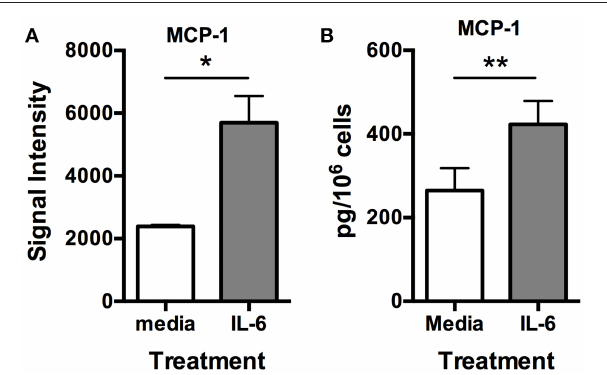
FIGURE 5 | IL-6 induces MCP-1 secretion from human skin mast cells. Human skin mast cells were treated or not with IL-6 (100ng/ml) for 24h, and the media was analyzed with the Human Angiogenesis Proteome Profiler TM Array (R&D Systems) (A) , or treated for 6h, and the media analyzed with ELISA for MCP-1 (B) . The data sets in (A) represent the mean signal intensity ± S.E.M. ( n = 4) obtained from membrane arrays incubated with media from individual mast cell cultures prepared from skin tissue of different donors. The graph bars in (B) represent MCP-1 concentration ± S.E.M. ( n = 3) obtained from individual mast cell cultures isolated from skin tissue of different donors. Significance was determined with Student’s t -test. * p < 0.05; ** p <